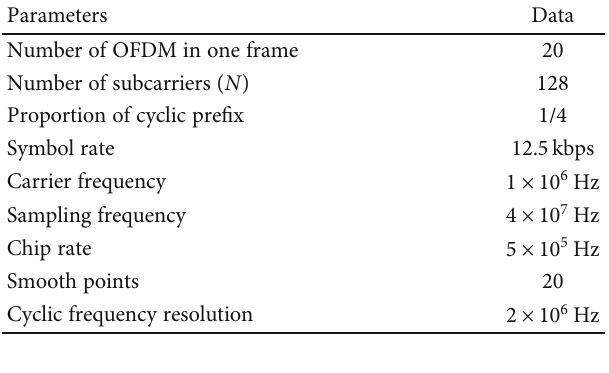
Table 1: Simulation experiment parameters.